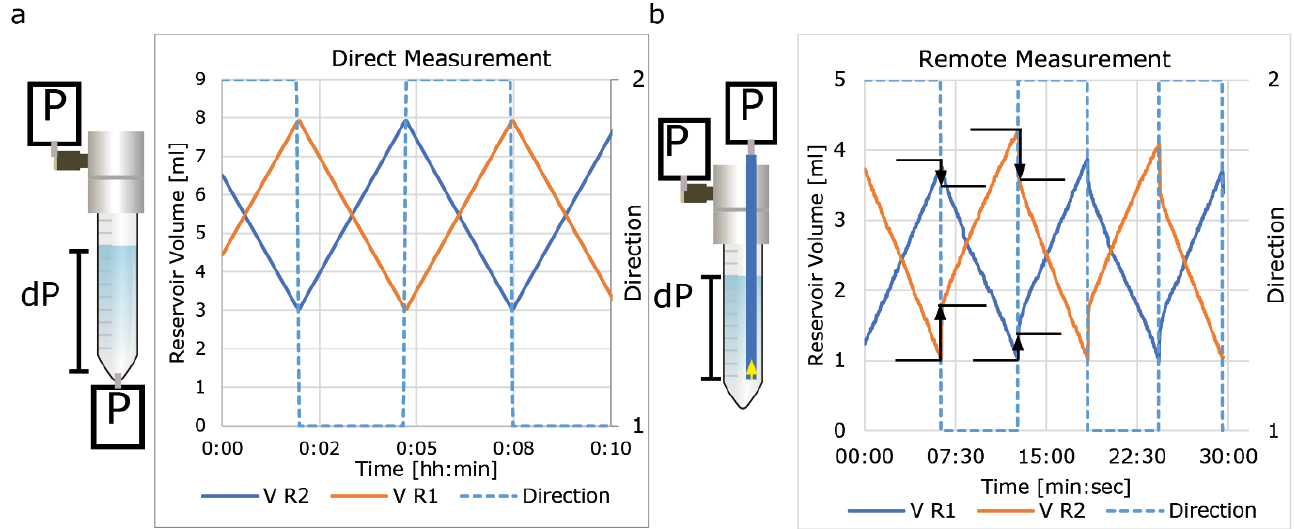
Figure 3. Measuring liquid level using pressure sensors. ( a ) Measurement of liquid level using direct measurement. ( b ) Remote measurement using tubes with 2 different diameters. Remote measurement is accurate; however, there is an offset when reservoirs are pressurized. This offset is diameter-dependent and larger with a small diameter (800 µm, orange) than with a larger diameter (3 mm, blue plot).